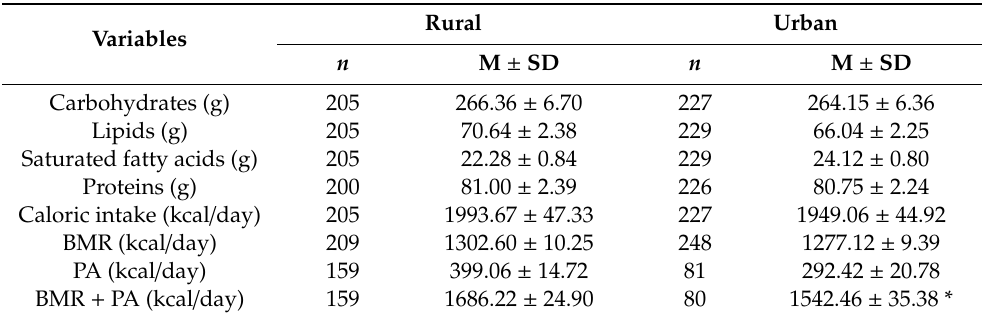
Table 4. Descriptive statistics and comparisons of dietary intake (DI) and caloric expenditure in rural and urban